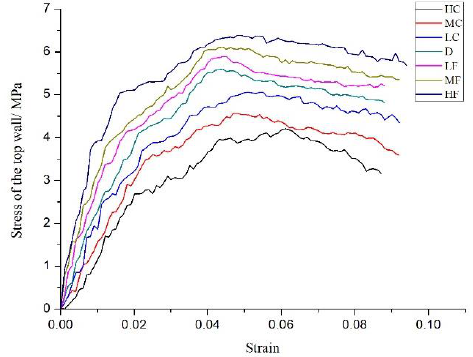
Figure 7. The stress-strain curves of the asphalt mixture.